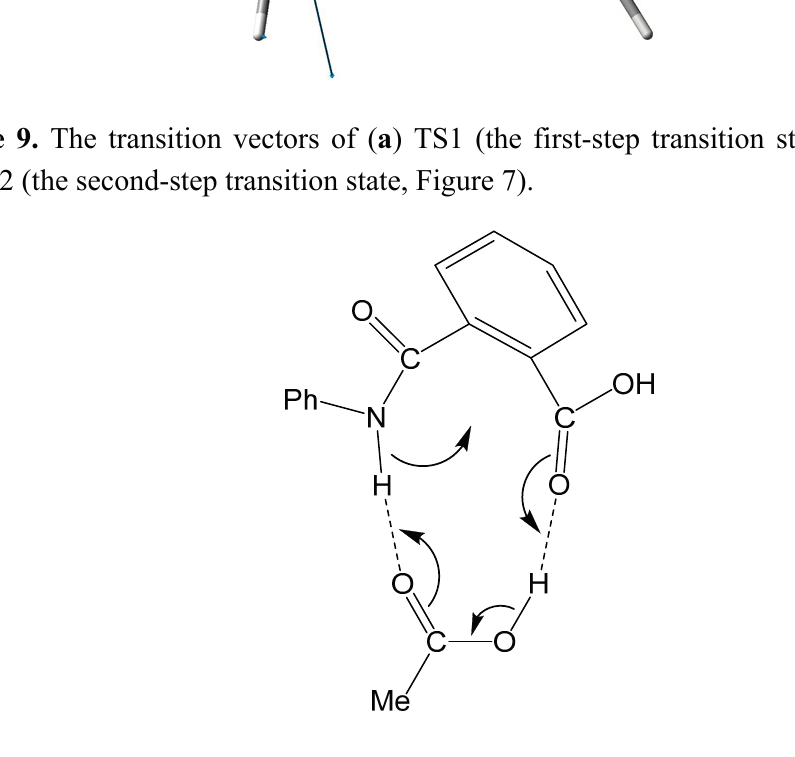
Figure 10. A curved-arrow representation of the extensive, concerted bond reorganization which occurs from the cyclic hydrogen-bonded reactant complex (RC) formed between phthalanilic acid and acetic acid. Dashed lines indicate hydrogen bonds. Ph, phenyl; Me,